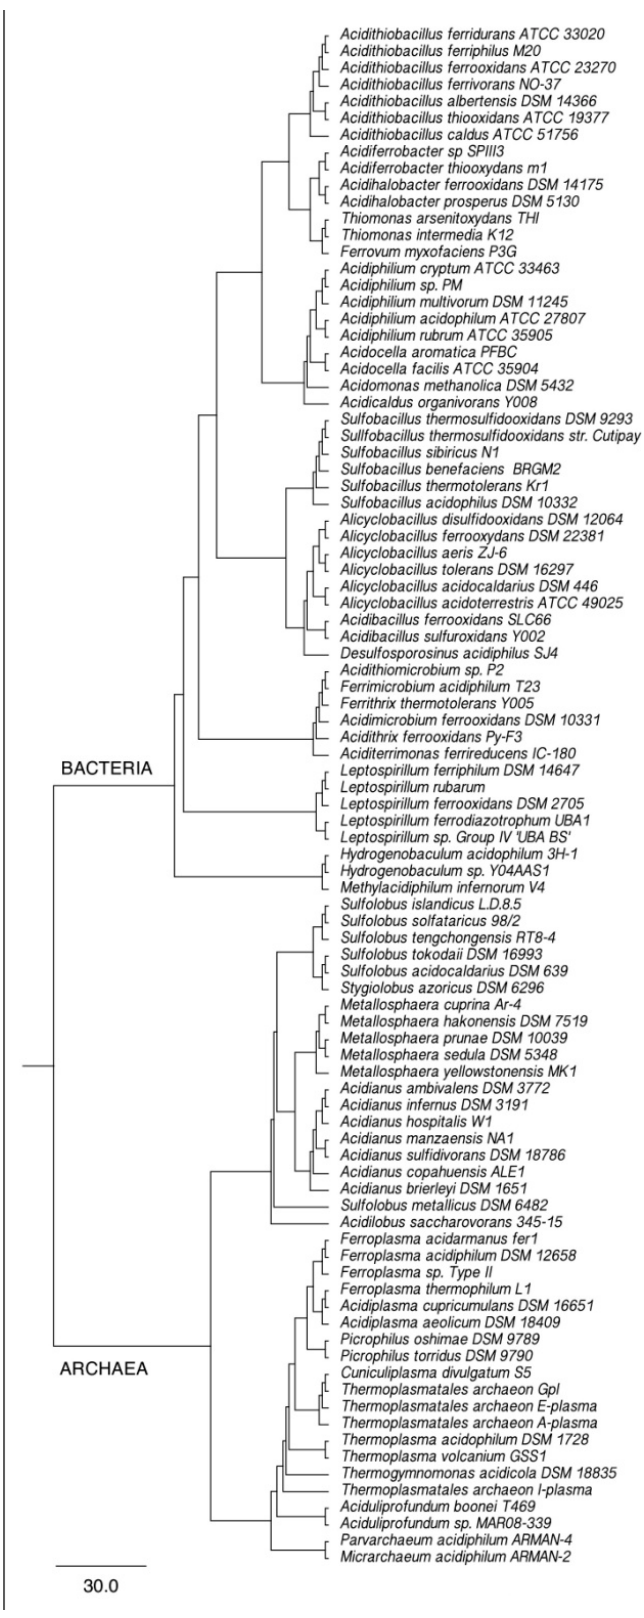
Figure 2. General scheme of phylogenetic diversity in the main groups of acidophilic bacteria and archaea capable of leaching metals [24] (open